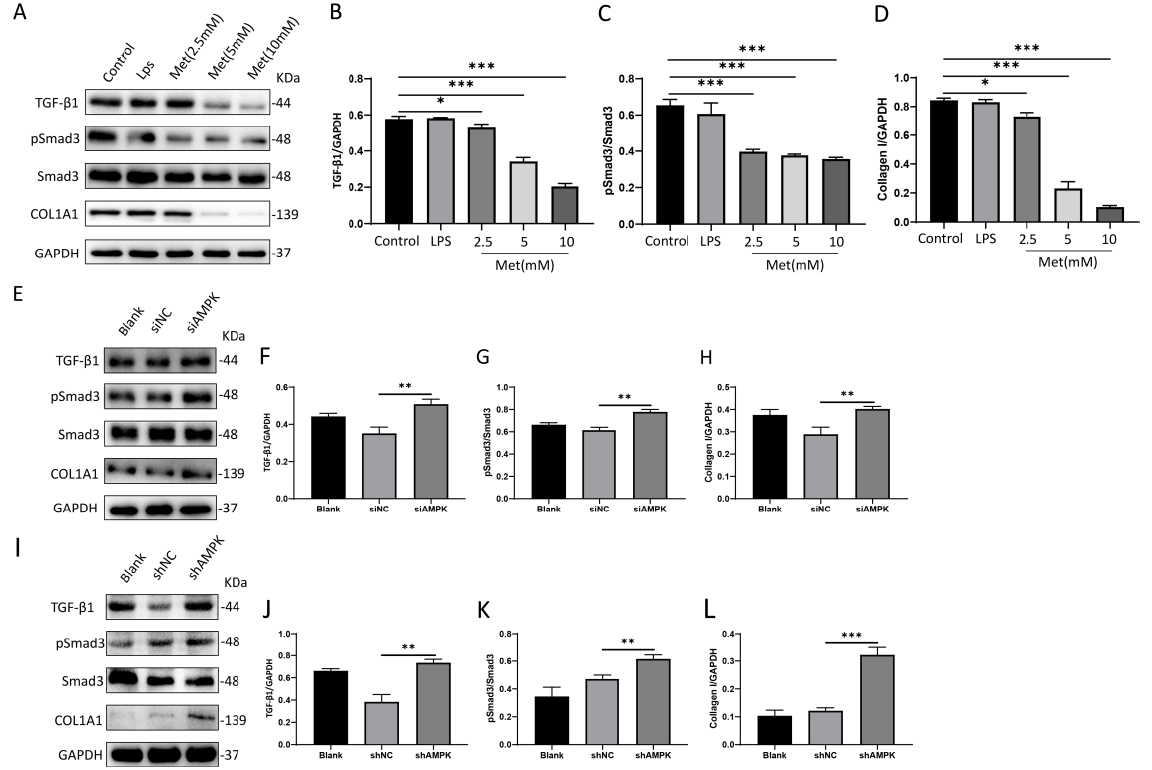
Figure 6. Metformin inhibits the TGF − β 1/Smad3 pathway in NIH 3T3 cells by activating AMPK, which in turn decreases the expression of collagen I. ( A – D ) NIH 3T3 cells were treated with metformin at doses of 2.5 mM, 5 mM, and 10 mM in a high-glucose medium for 24 h. Protein levels of TGF β -1, phosphorylated Smad3 (pSmad3), Smad3, and collagen I were determined by Western blotting and analyzed by densitometry. The representative data are shown. ( E – L ) Representative Western blots and quantitative results for TGF β -1, phosphorylated Smad3 (pSmad3), Smad3, and collagen I proteins. All data are expressed as the means ± SDs of values from triplicate experiments. * p < 0.05, ** p < 0.01, and *** p < 0.001. Control: NIH 3T3 cells, LPS: NIH 3T3 cells treated with 1 µ g/mL LPS for 24 h, Met (2.5 mM): NIH 3T3 cells treated with 2.5 mM metformin for 24 h, Met (5 mM): NIH 3T3 cells treated with 5 mM metformin for 24 h, Met (10 mM): NIH 3T3 cells treated with 10 mM metformin for 24 h, Blank: NIH 3T3 cells, siNC: siAMPK negative control group, siAMPK: NIH 3T3 cells transfected with si − Prkaa1 − mus − 1337, shNC: lentivirus AMPK negative control group, shAMPK: lentivirus AMPK knockdown group